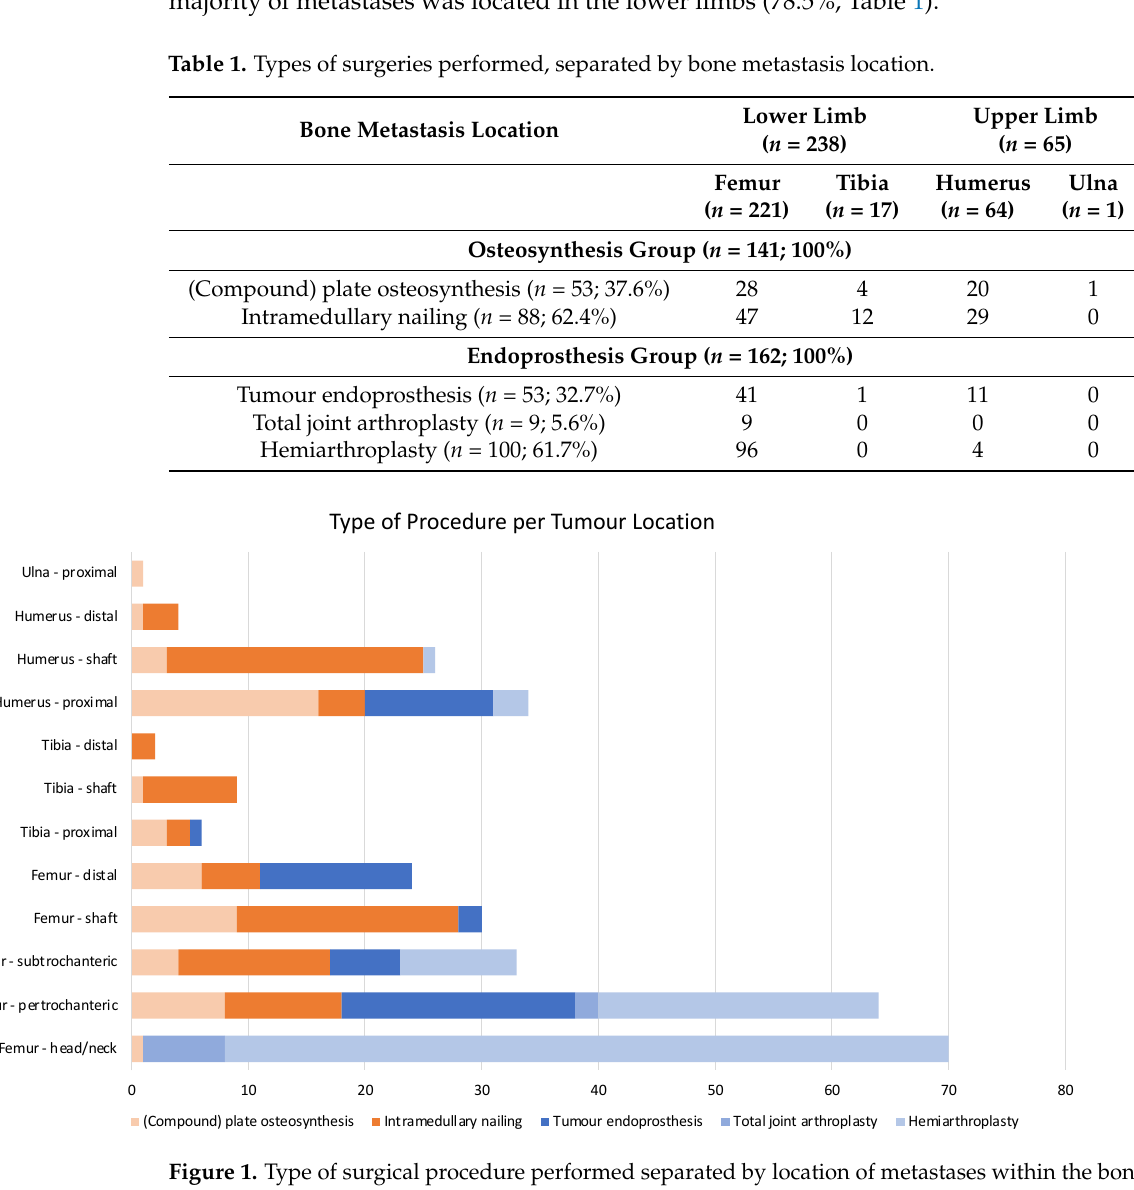
Figure 1. Type of surgical procedure performed separated by location of metastases within the bone. Table 1. Types of surgeries performed, separated by bone metastasis location.